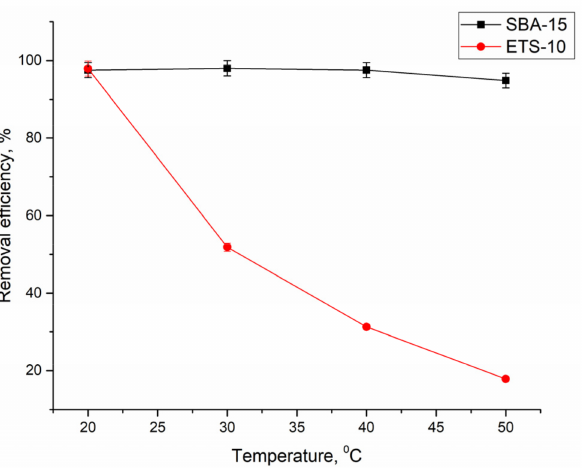
Figure 9. Influence of temperature on Ce(III) removal by silica SBA-15 and titanosilicate ETS-10